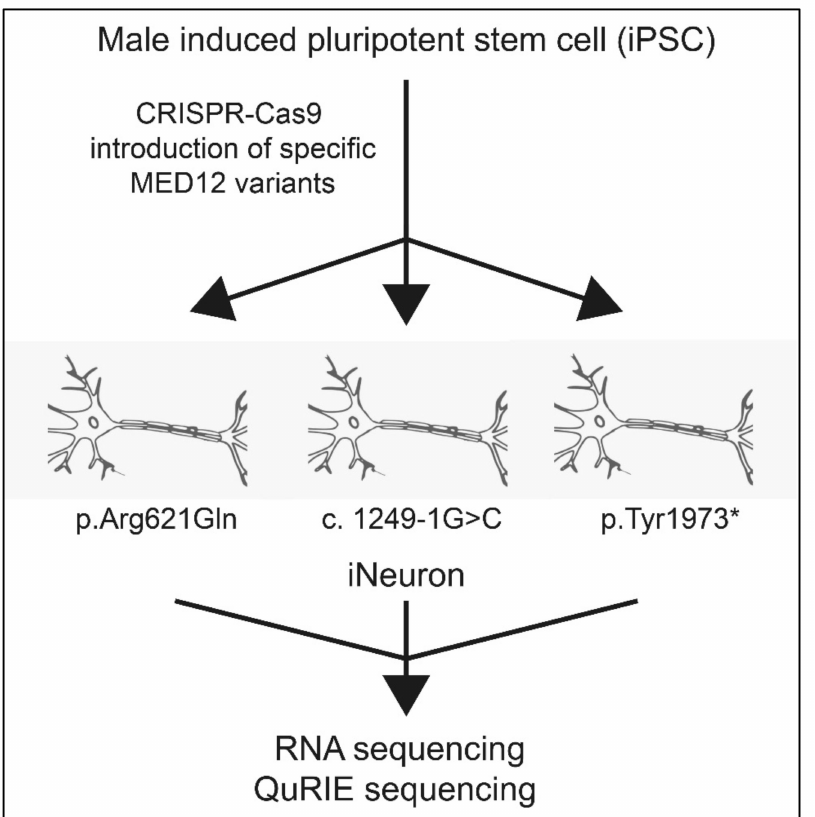
Figure 5. General approach to determine pathogenicity of MED12 variants. Firstly, an isogenic male iPSC is generated which also serves as a control. Then by use of CRISPR-Cas, the novel variants are introduced in the cells (e.g., p.Arg621Gln, c.1249-1G>C), pTyr1973*). These cell lines are subsequently sequenced and the differentially expressed genes as compared to a control are selected through an AI